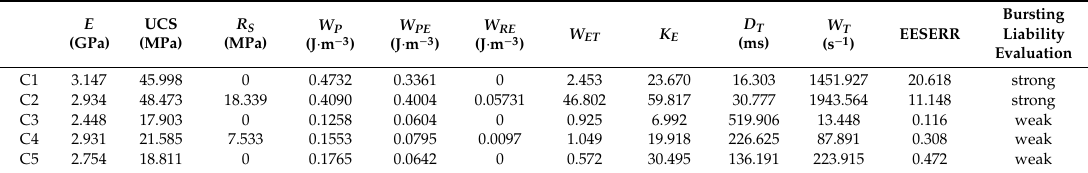
Table 2. Mechanical parameters and bursting liability indexes for coal samples from the Tashan coal mine, Shanxi Province, tested under uniaxial compression.